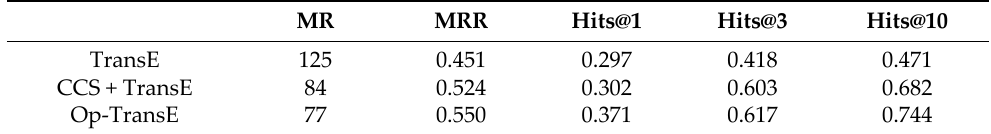
Table 8. Experimental results on the FB15K compared with the TransE model.